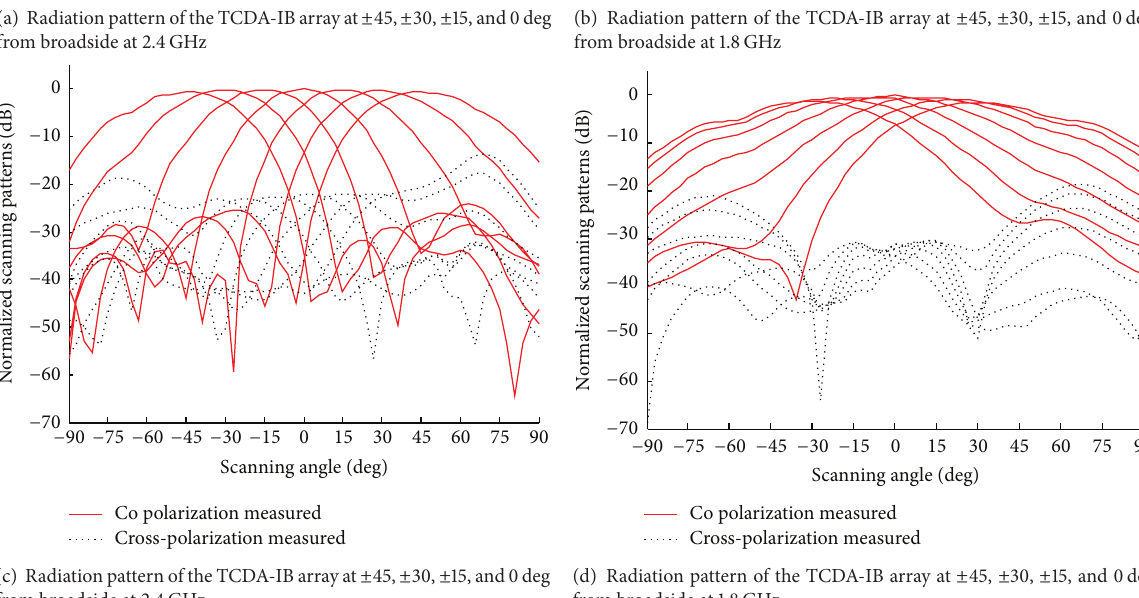
(a) RadiationpatternoftheTCDA-IBarrayat ± 45, ± 30, ± 15,and0deg from broadside at 2.4GHz